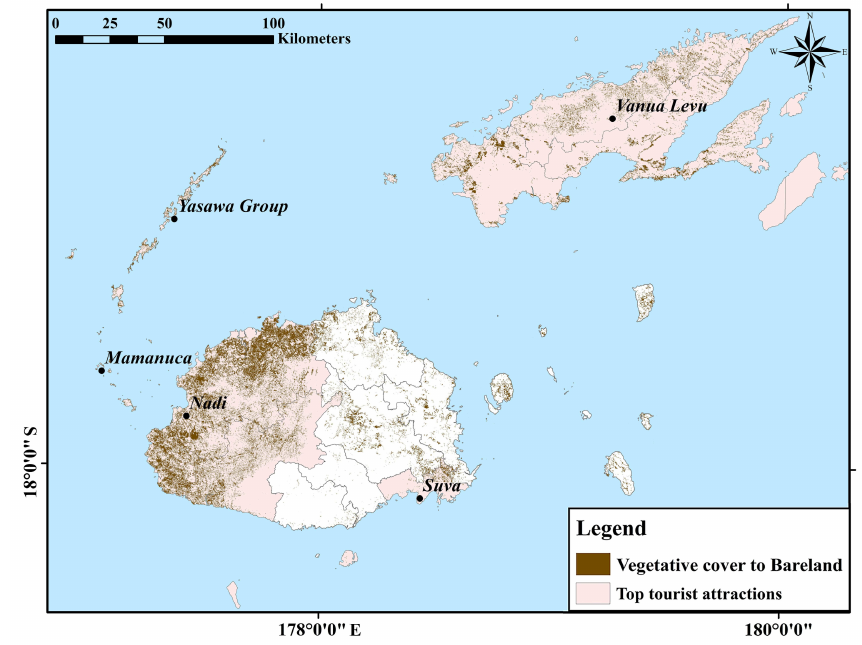
Figure 9. Distribution of bare land (data from Figure 5b) in Fiji in 2014 and the popular tourist attractions. Data come from the Economic and Commercial Counseling Office of the Chinese Embassy in Fiji